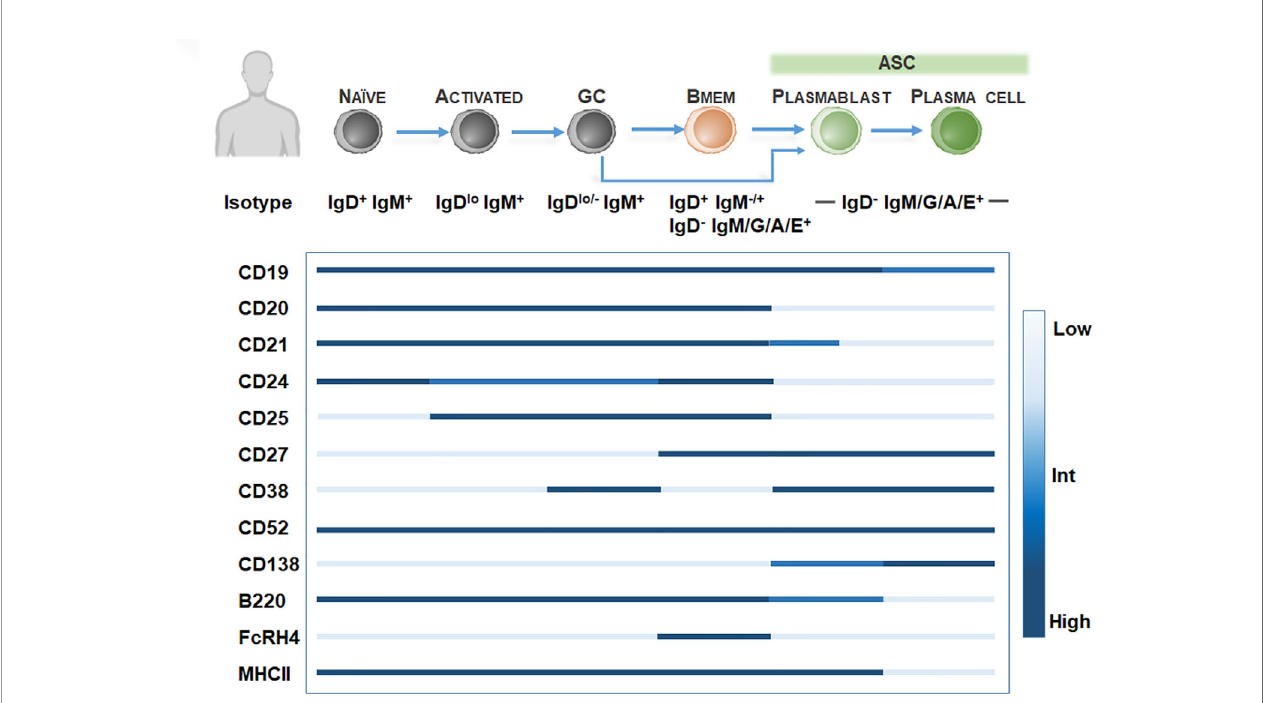
FIGURE 1 | Bmem phenotyping markers in humans. Overview of B cell differentiation in humans, focusing on naïve B cell to ASC phenotypes, with BCR isotype and surface marker expression. Surface marker levels simpli fi ed to highlight relative expression, including low, intermediate, or high